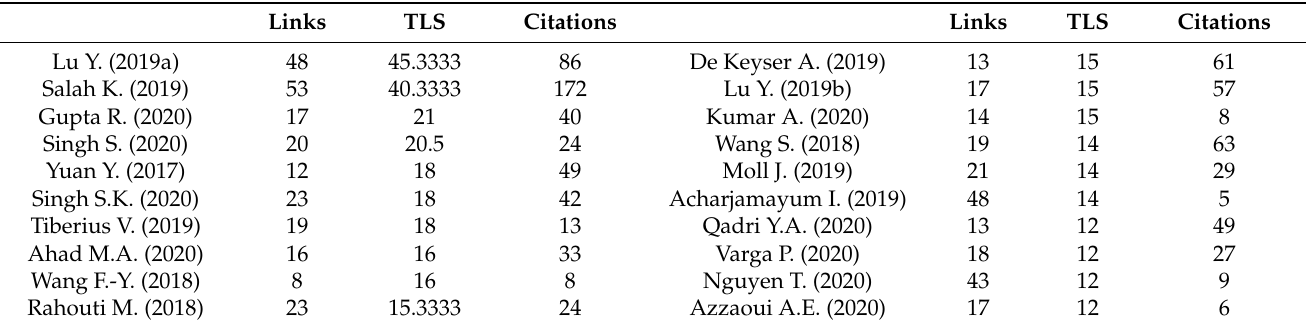
Table 13. Links, TLS, and citations for bibliographic coupling of documents.